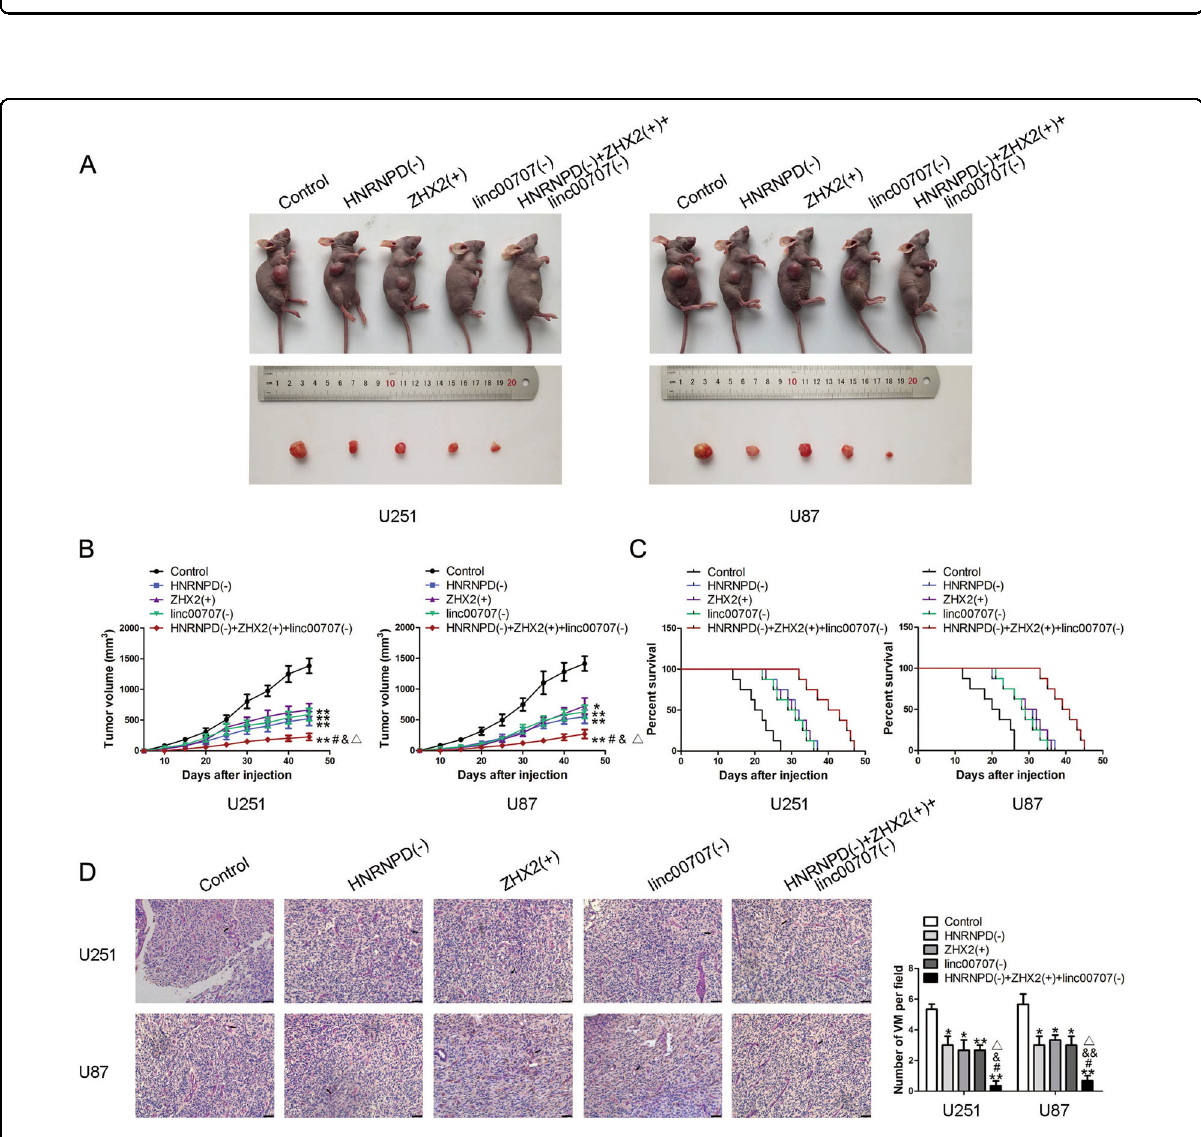
Fig. 8 Tumor xenograft studies. A The nude mice carried tumors from respective groups were shown. The sample tumors from respective groups were shown. B Tumor growth curves were shown. * P < 0.05, ** P < 0.01 vs. control group; # P < 0.05 vs. HNRNPD( − ) group; & P < 0.05 vs. ZHX2( + ) group; △ P < 0.05 vs. linc00707( − ) group. Using one-way analysis of variance for statistical analysis. C Survival curves from nude mice were shown ( n = 8, each group). D CD31-PAS staining was used to detect the VM structures in xenografted tumor. Data are presented as mean ± SD ( n = 8, each group). * P < 0.05,** P < 0.01 vs. control group; # P < 0.05 vs. HNRNPD( − ) group; & P < 0.05, && P < 0.01 vs. ZHX2( + ) group; △ P < 0.05 vs. linc00707( − ) group. The scale bar represents 50 µm. The arrow indicates the VM